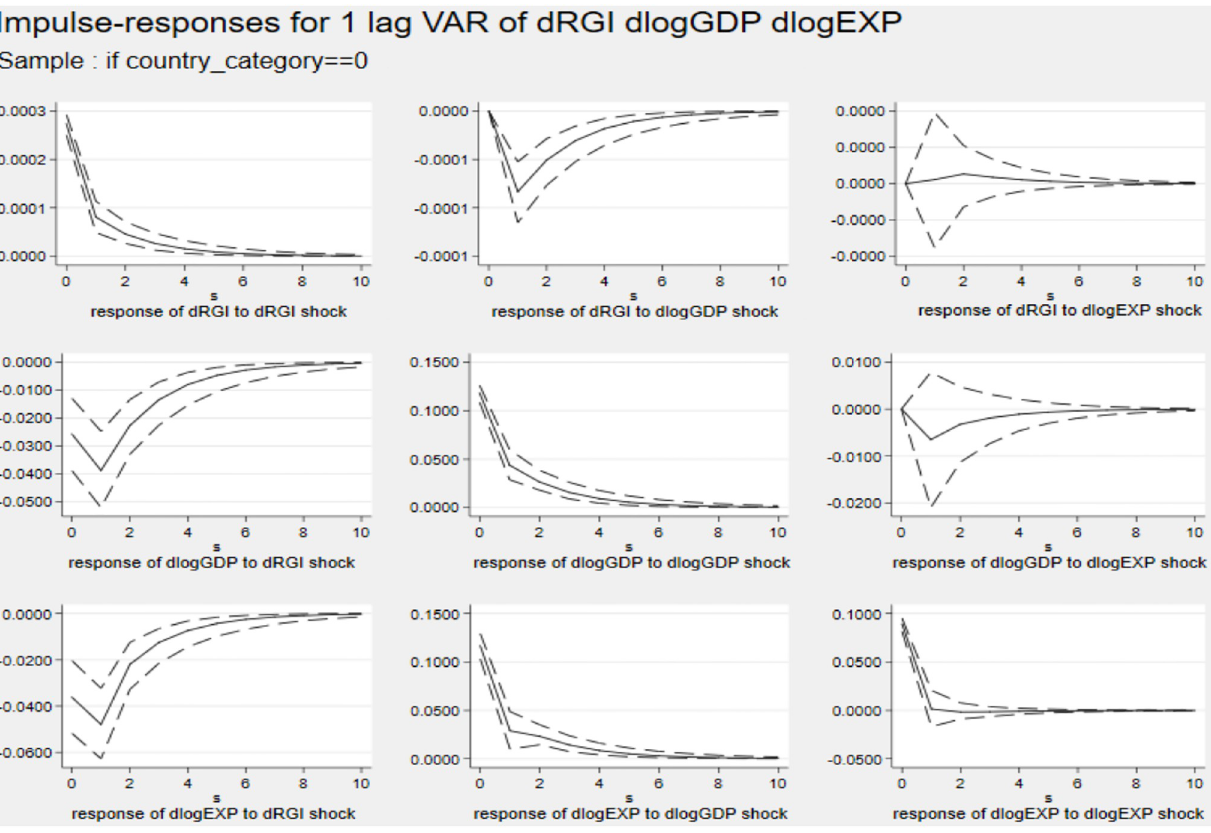
Fig 2. Impulse response diagram in Cluster 1. Notes : Errors are 5% on each side generated by Monte-Carlo with 2000 reps.